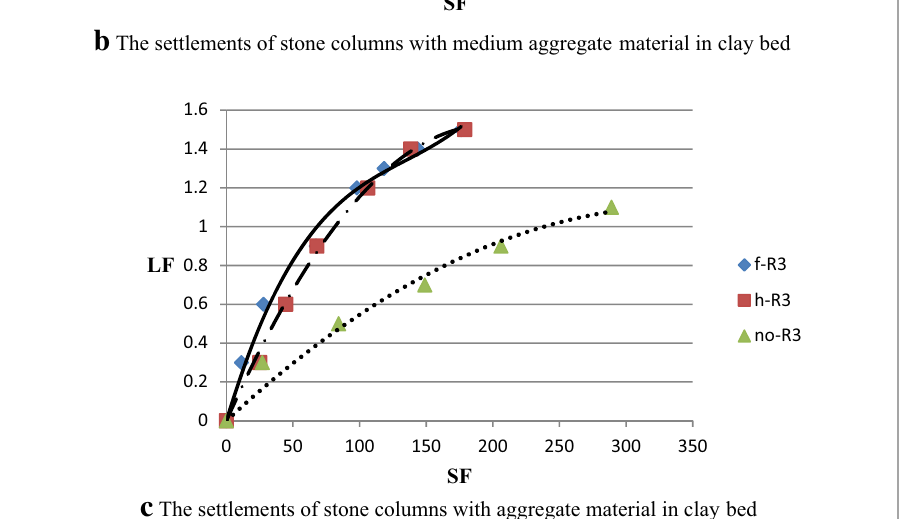
Figure 6a–c show the results of compression tests on non-encased and encased stone